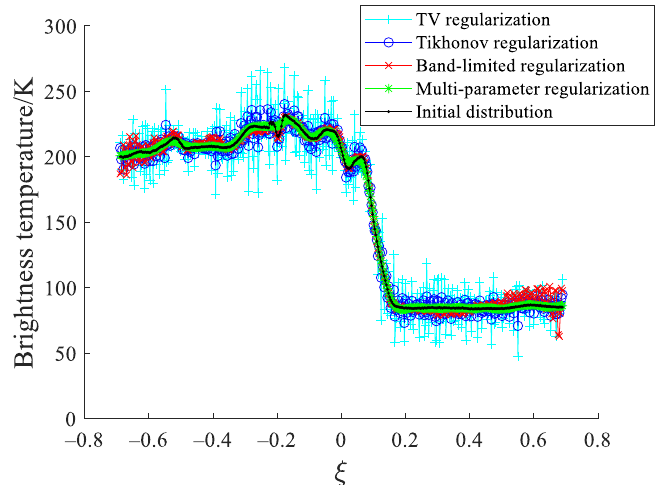
Figure 7. Reconstructed results of the coast in the alias-free field of view.